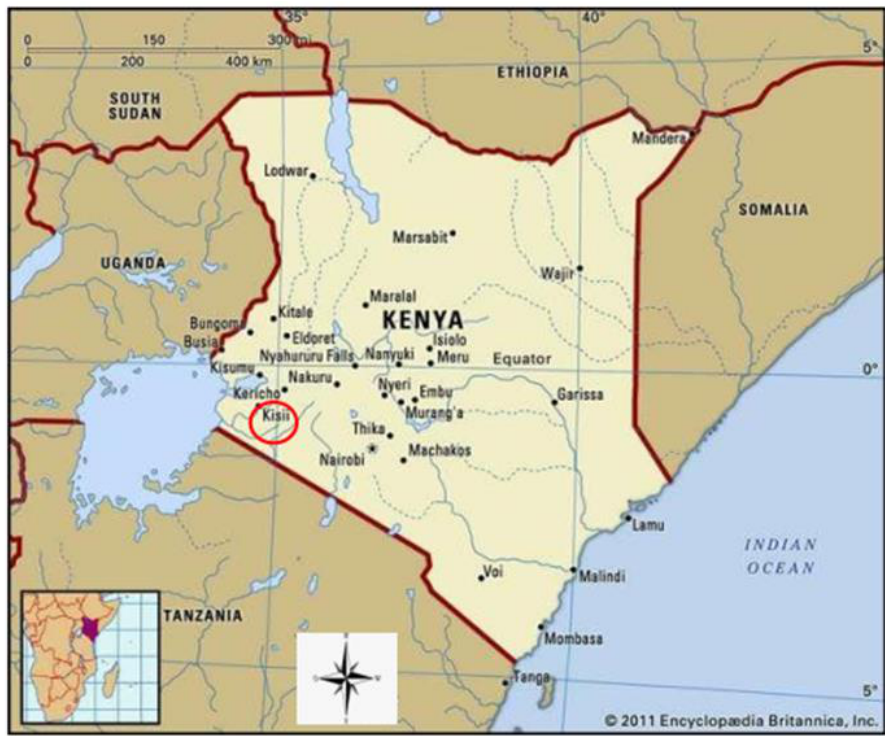
Fig. 1: Location of Kisii Town, the study area (Encyclopedia Britannica, 2011)